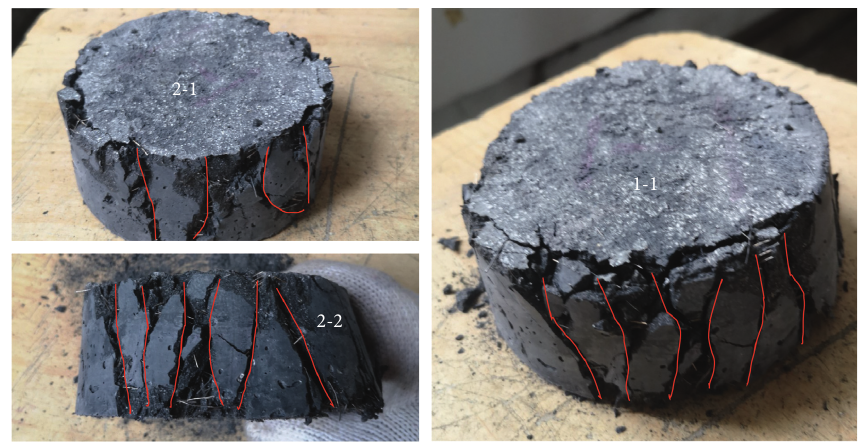
Figure 12: Failure modes of the first and second sets of turntable specimens.